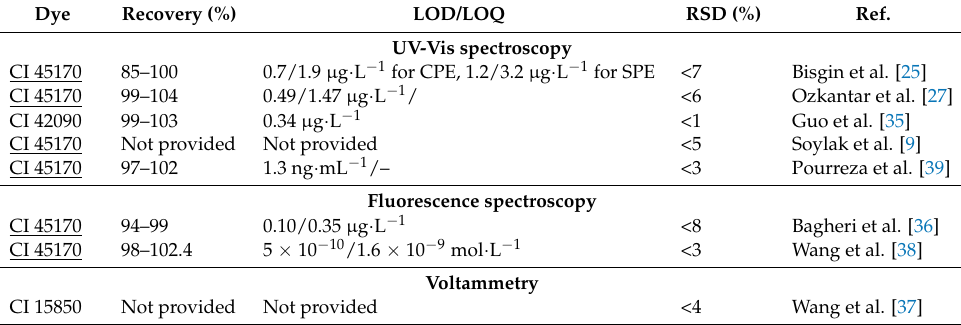
Table 4. Performance of analytical methodologies for only one dye determination in cosmetics